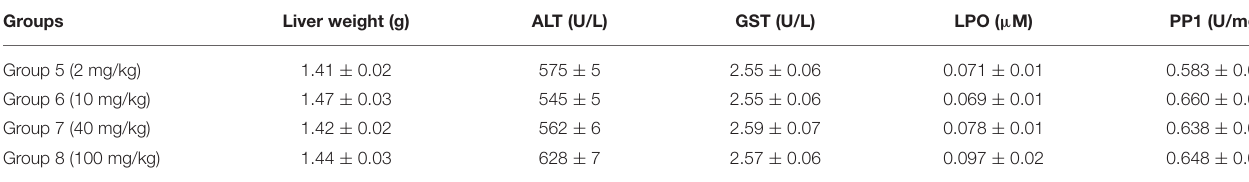
TABLE 2 | Effects of various concentrations of cucurbit[7]uril (CB7) on liver function in BALB/c mice; 10 mice per group ( n = 10). Groups Liver weight